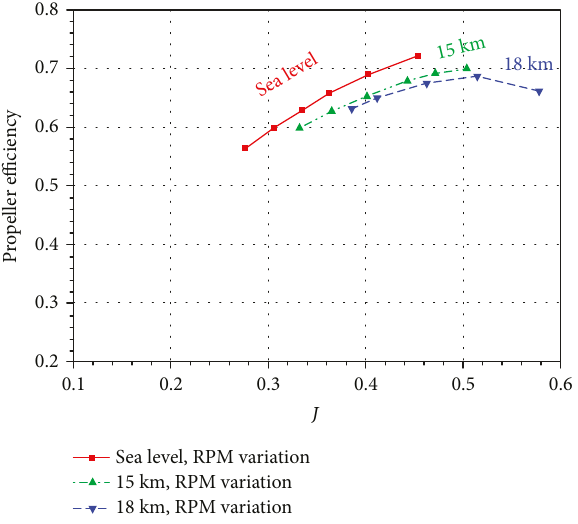
Figure 23: E ffi ciency curves at several altitude